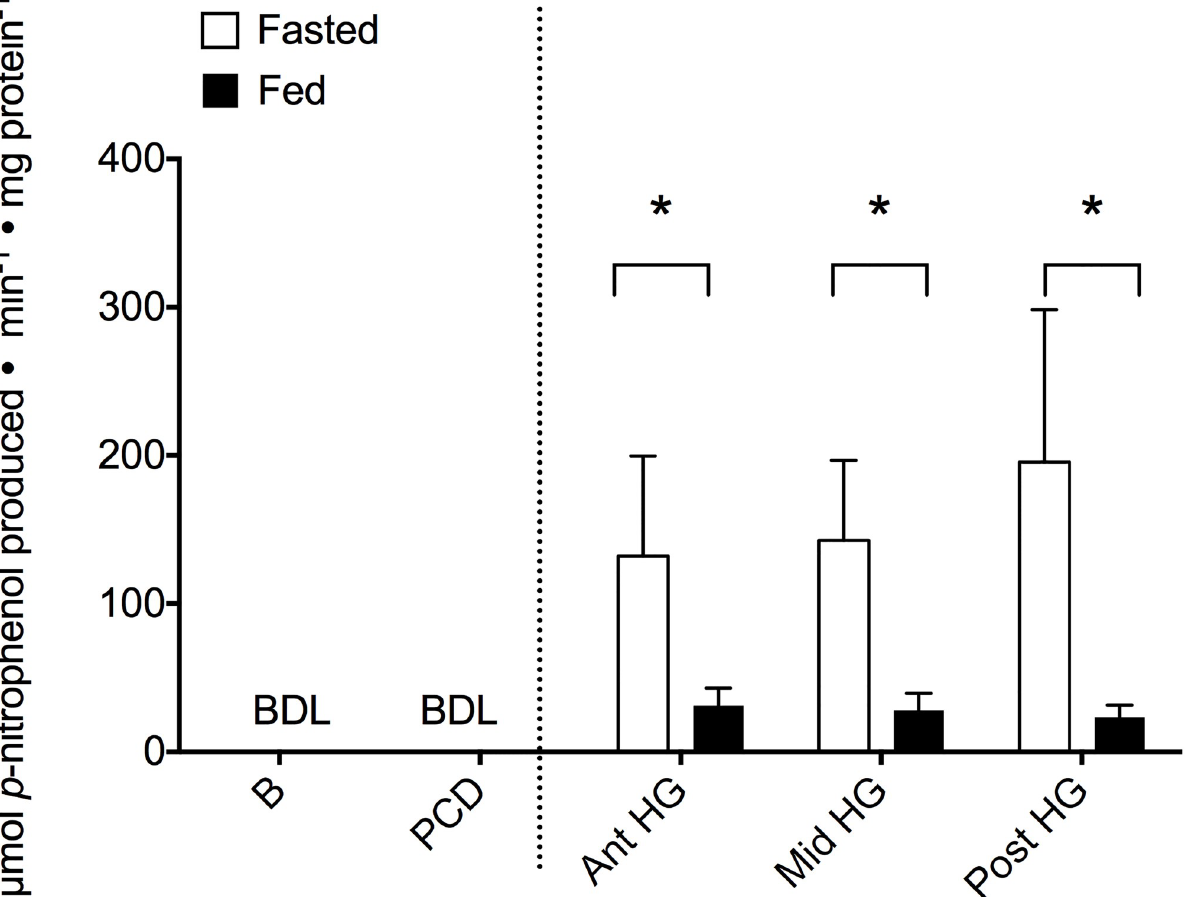
Fig 6. Feeding alters alkaline phosphatase activity ( μ mol p -nitrophenol produced min -1 mg protein -1 ) within the entire hagfish hindgut. Activity was measured in both fasted (white bars) and fed (black bars) hagfish in five locations down the alimentary canal (B—buccal cavity, PCD— pharyngocutaneous duct, Ant HG—anterior hindgut, Mid HG—mid hindgut, Post HG—posterior hindgut). Bars represent means + s.e.m. of 6–12 preparations. No activity was detected in the anterior portion of the alimentary canal (BDL = below detectable limits). Therefore, a 2-way ANOVA was conducted for the hindgut regions alone (right of the dotted line) with significance accepted at α = 0.05. Asterisks ( � ) denote significant differences between feeding states.